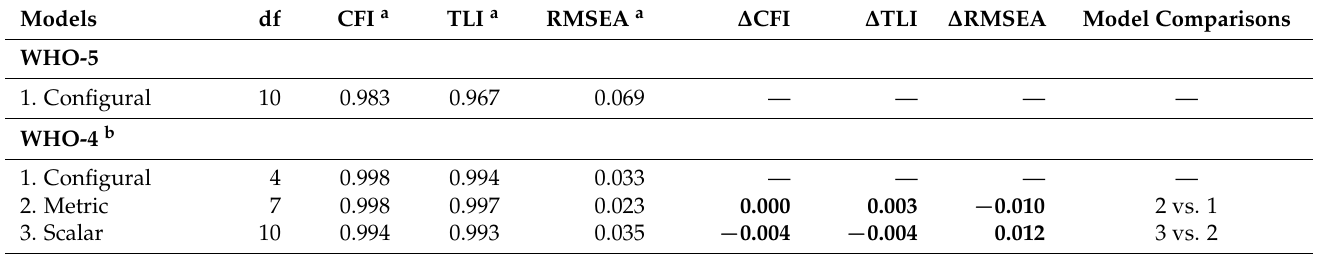
Table 4. Measurement invariance testing by gender ( N = 74,071).